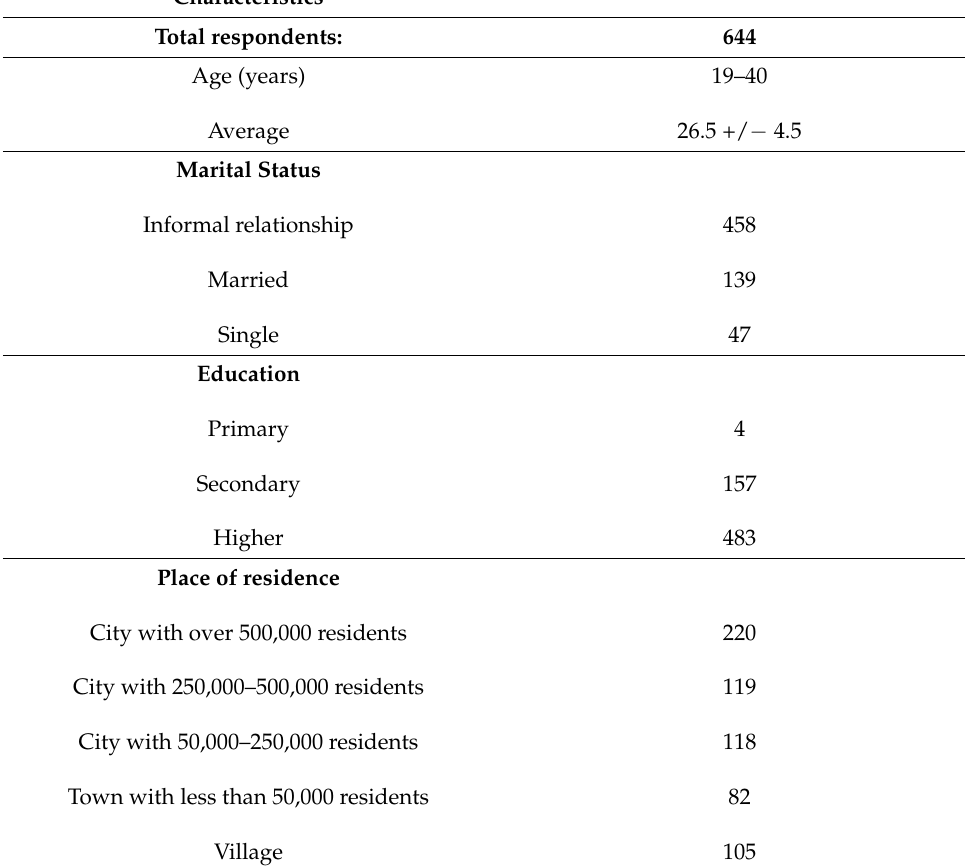
Table 1. Demographic characteristics of the study